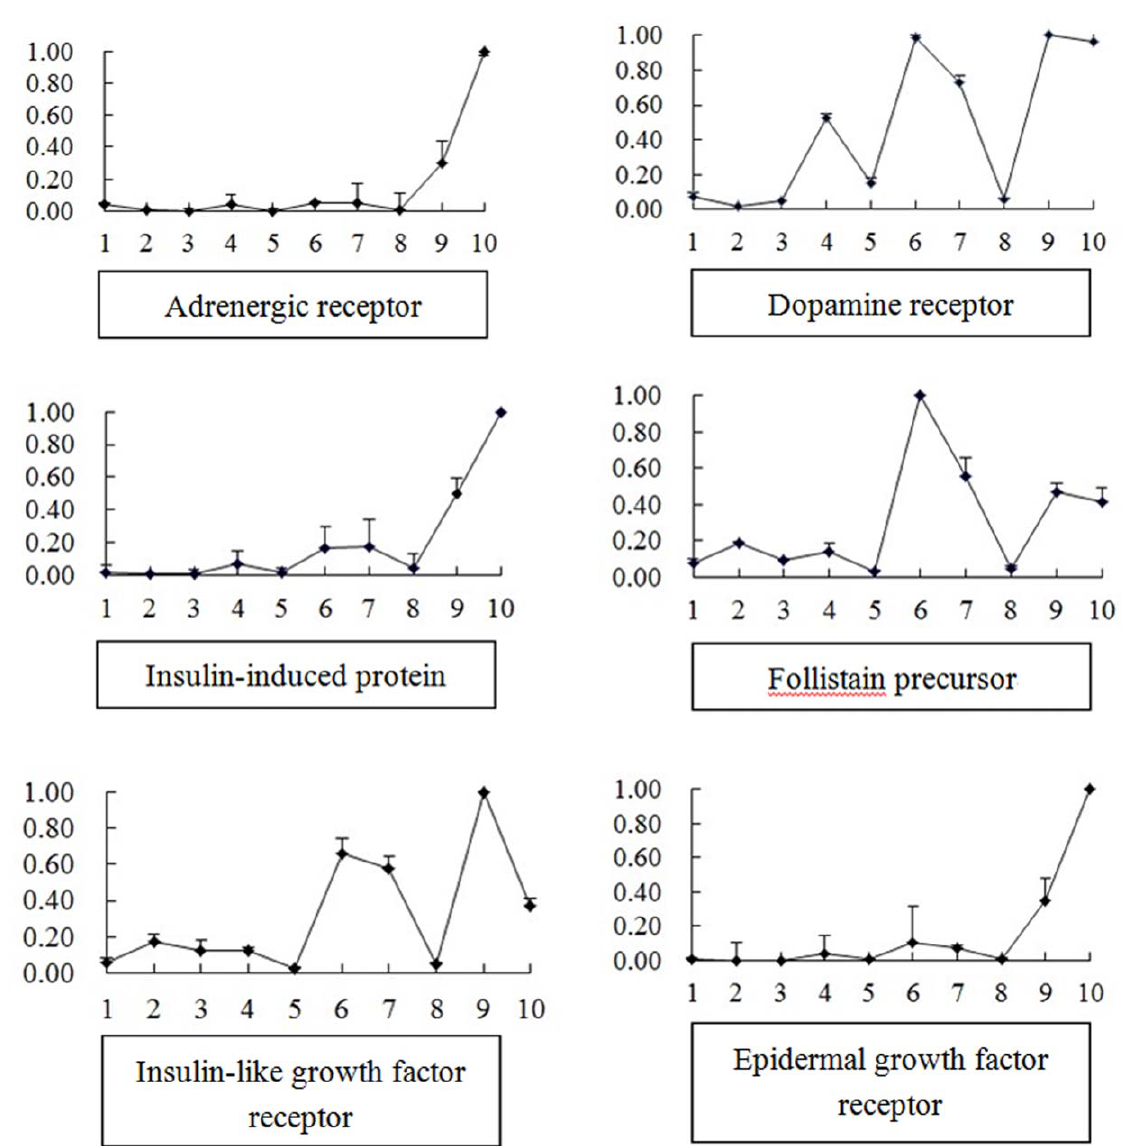
Figure 3. Gene expression in different developmental stages of Fujian Oyster (1: Eggs; 2: Gastrula; 3: Trochophore; 4: D-larvae; 5: Umbo larvae; 6: eye spot larvae; 7:0.5 h after settlement; 8:6 h after attachment; 9:9 h after attachment; 10:24 h after